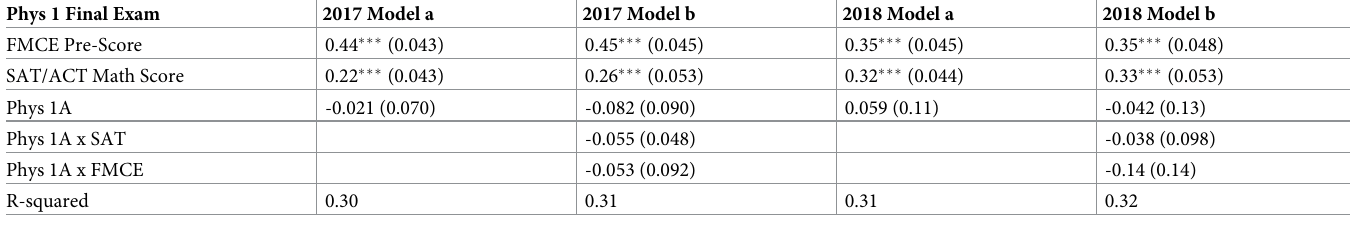
Table 2. Regression models for Phys 1 final exam performance as a function of incoming preparation and enrollment in Phys 1A. Coefficients are in units of stan- dard deviations and the numbers in parentheses are the standard